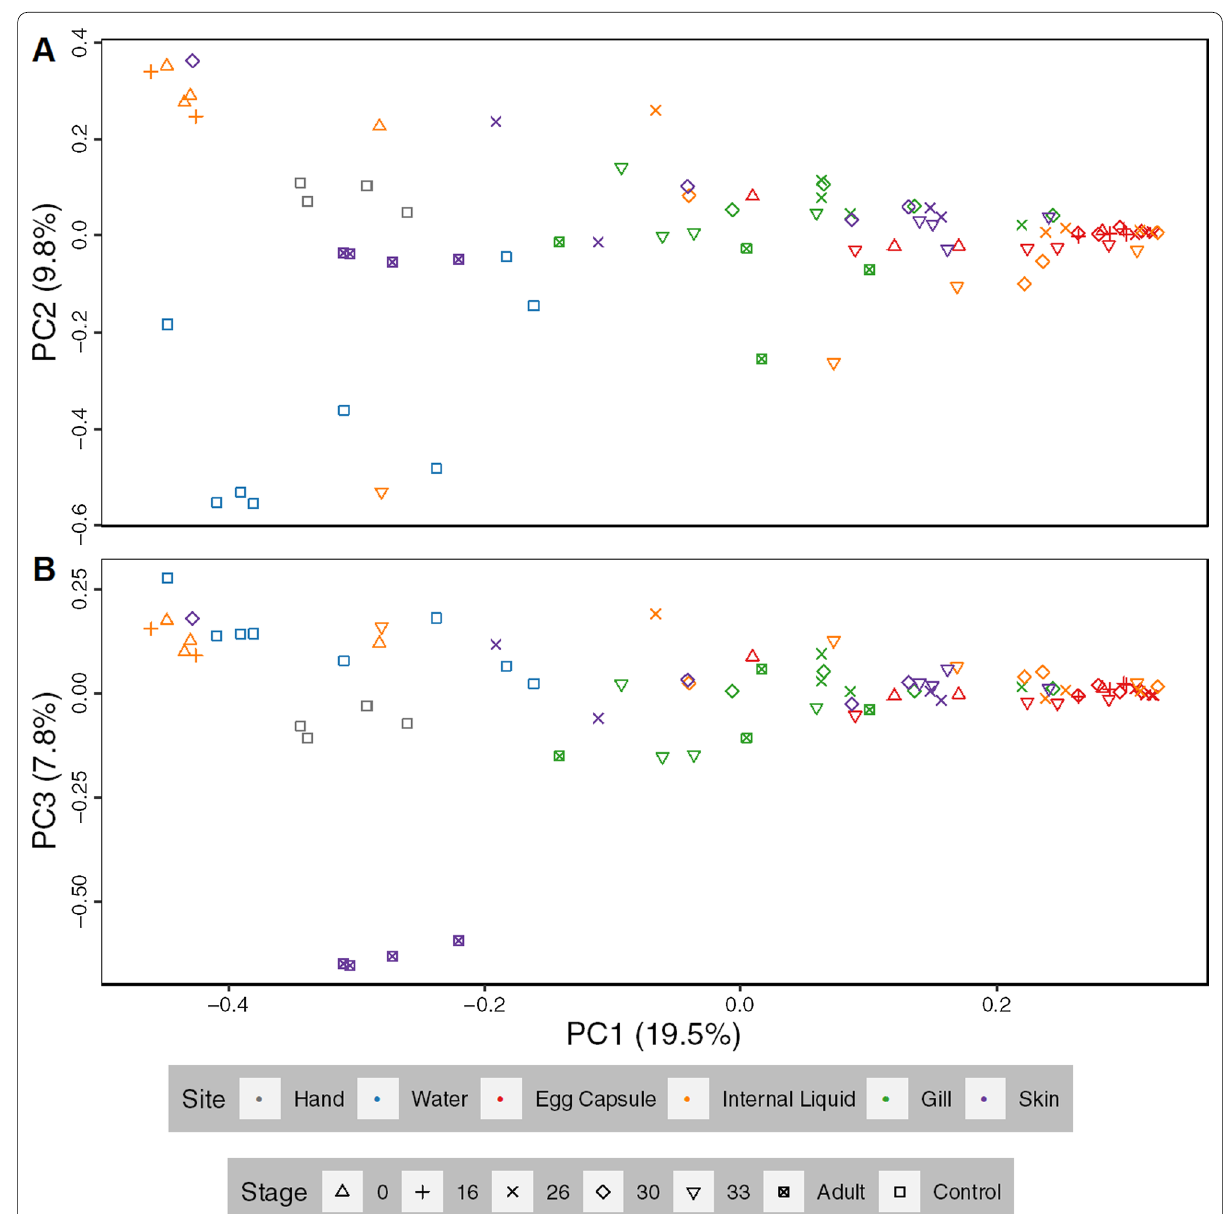
Fig. 2 Principal coordinate analysis plots of little skate bacterial samples. PCoA analysis (Bray–Curtis) of skate and control samples. PC1 versus PC2 ( A ) and PC1 versus PC3 ( B ). Sample distribution the same as in Fig.